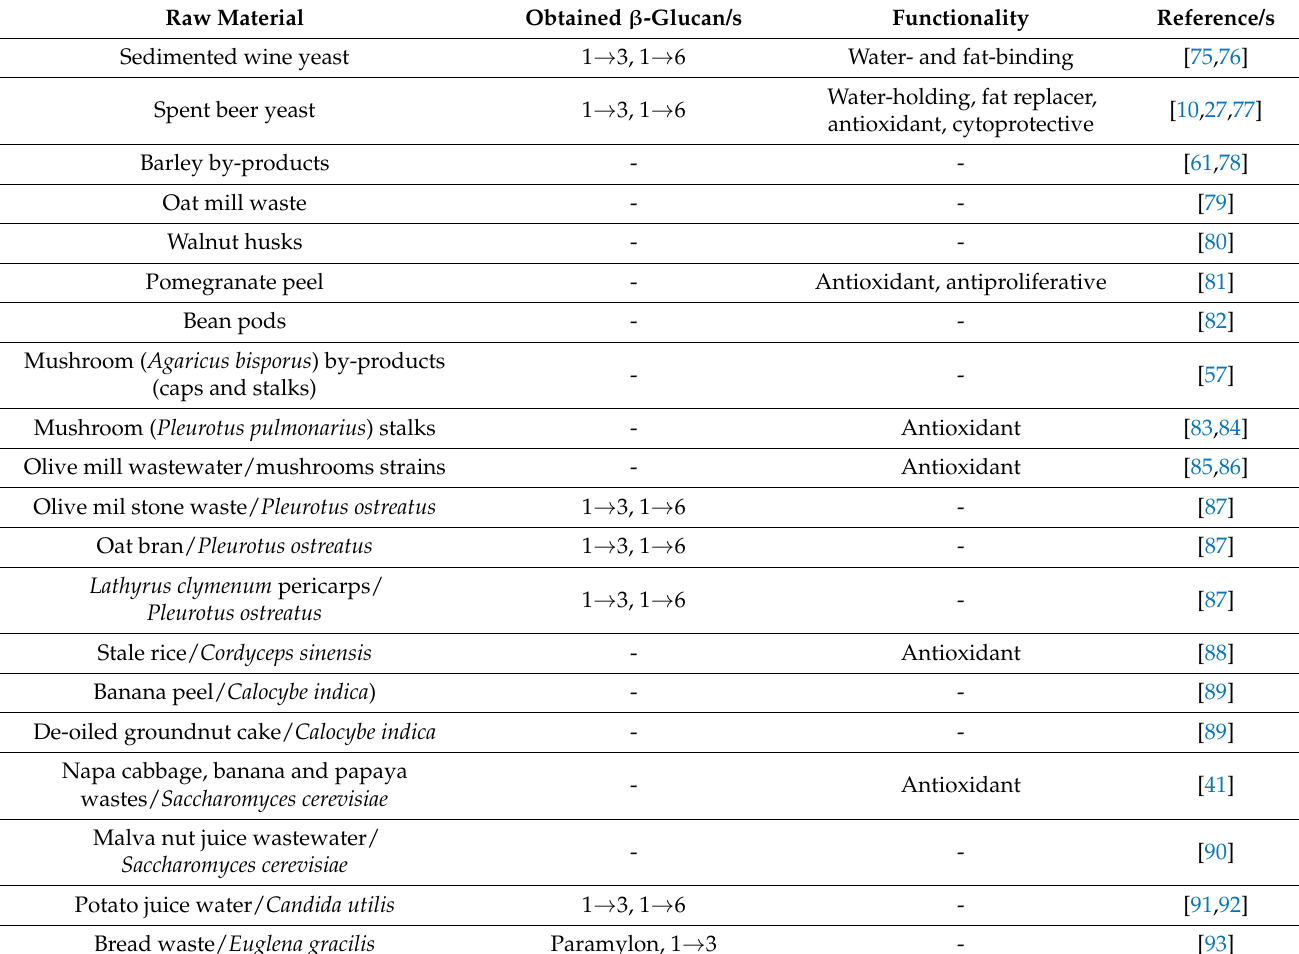
Table 3. Examples of food by-products and agro-industrial wastes as a source of β -glucans with potential biological or technological